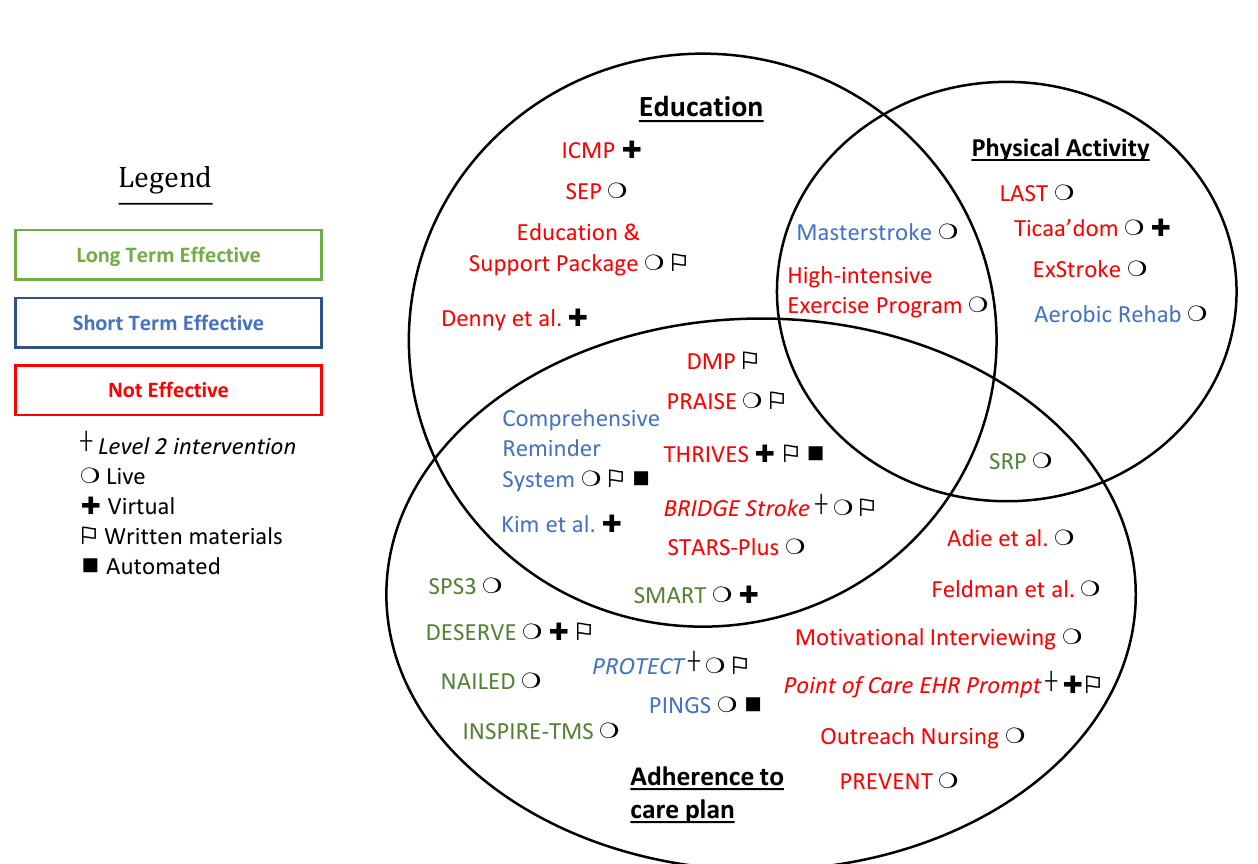
Figure 1. Provides a visual aid for navigating which studies utilized adherence to the care plan, physical activity, and education as their primary outcome and if the setting was live, virtual, written materials, automated, Level 1, or Level 2. Red studies were not effective, blue were short-term effective, and green were long-term effective, as labeled in the figure legend. Many studies combined two outcomes, but no studies utilized all